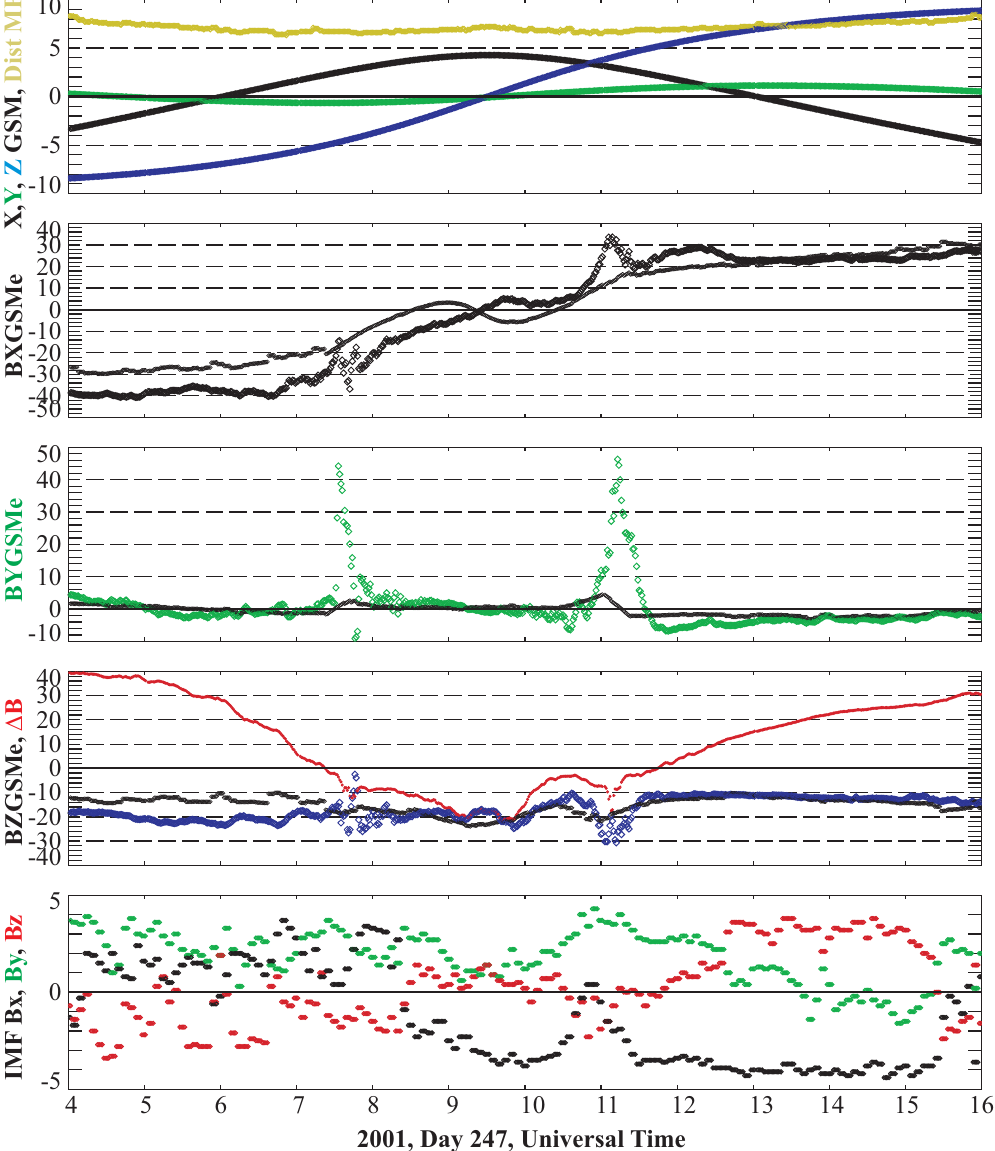
Fig. 2. An example of crossing the polar cusps by Cluster on 28 August 2001. Five panels, from top to bottom, show the spacecraft GSM position (X,Y,Z), three components of the observed (larger dots) and model (T96, smaller dots) magnetic field (only external part with the IGRF field removed; hence the “e” suffix), and three components of the concurrent IMF. Red trace in the BzGSMe panel displays the variation of the “scalar anomaly” 1B =| B obs |−| B IGRF | . Note that both the Cluster B y spikes and the IMF B y have the same negative polarity in this